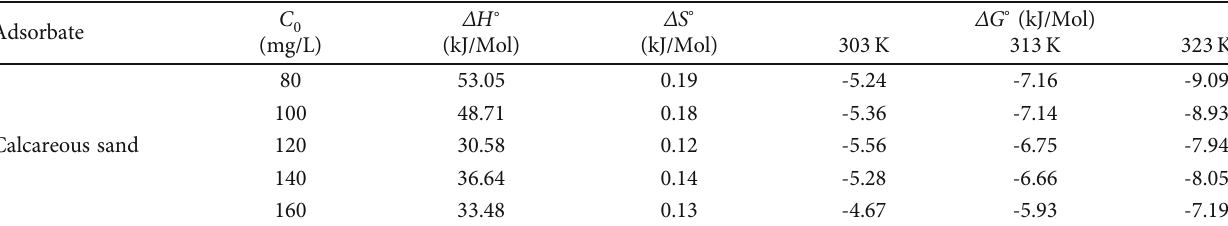
Figure 4: Linear relationship between lnK and 1/ T ( K − 1 ) adsorbed by GO on calcareous sand. d Table 2: Adsorption thermodynamic